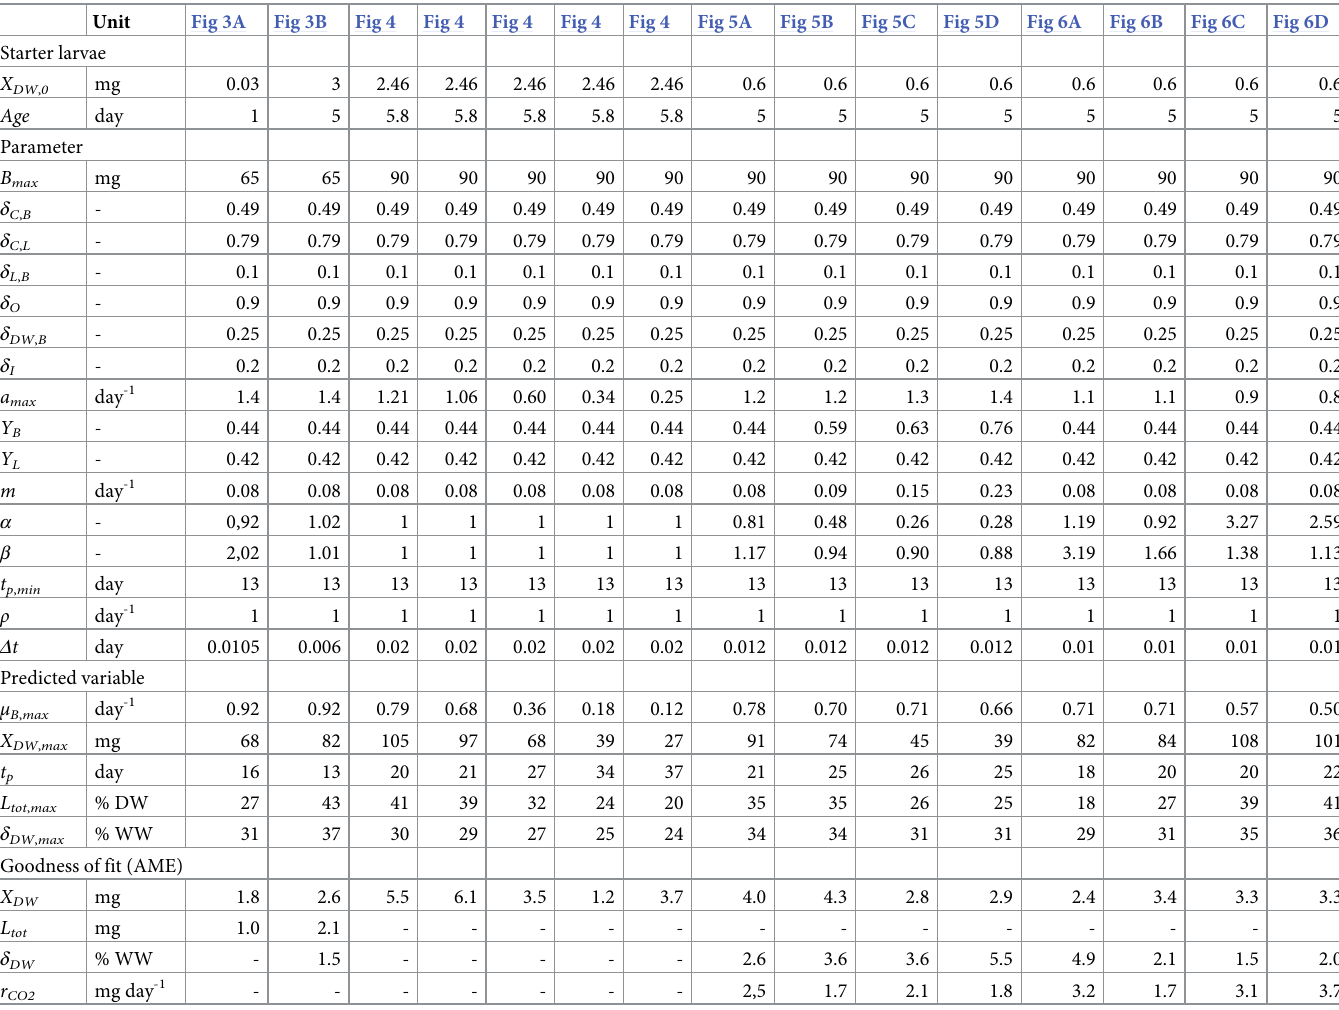
Table 2. Parameters used for modelling of growth of BSF larvae shown in Figs 3–6, and selected variables predicted from the modelled results.